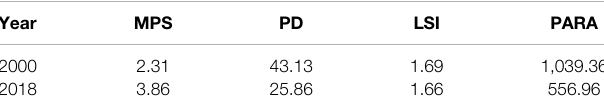
TABLE 4 | Landscape metrics change of rural settlements in Pudong in 2000 and 2018.